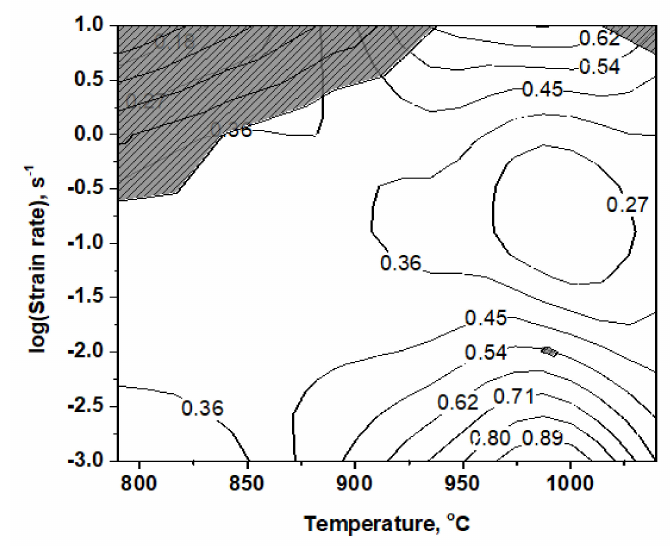
Figure 8. Power dissipation map for Ti6Al4V-5Cu alloy obtained by hot compression experiment in strain rate range of 10 − 3 –10 s − 1 with a strain of 0.4, showing stable and instable regions. The contour number represents the power dissipation efficiency ( η ). In the single β -phase region, η decreased with the increase in strain rate in the range of 10 − 3 s − 1 to 10 − 1 s − 1 . Whereas at higher strain rates (>1 s − 1 ), the η increased with the increase in